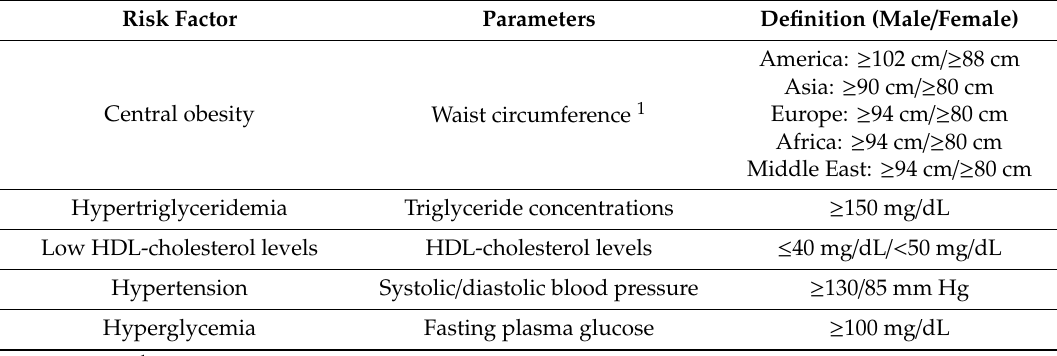
Table 1. Risk factors associated with metabolic syndrome and definition of the parameters for its